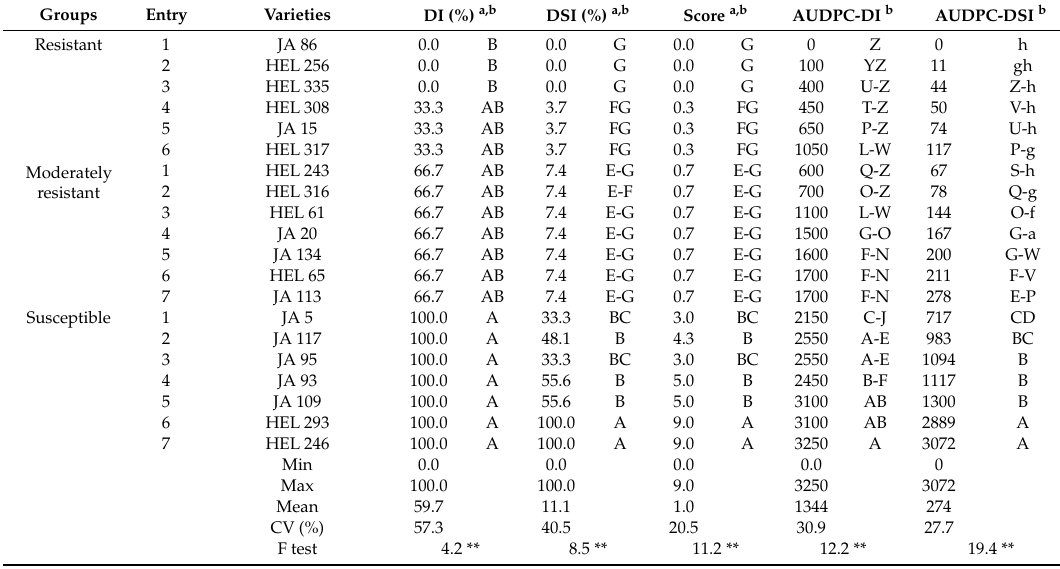
Table 4. Selected varieties of resistant, moderately resistant and susceptible Jerusalem artichoke evaluated in late rainy